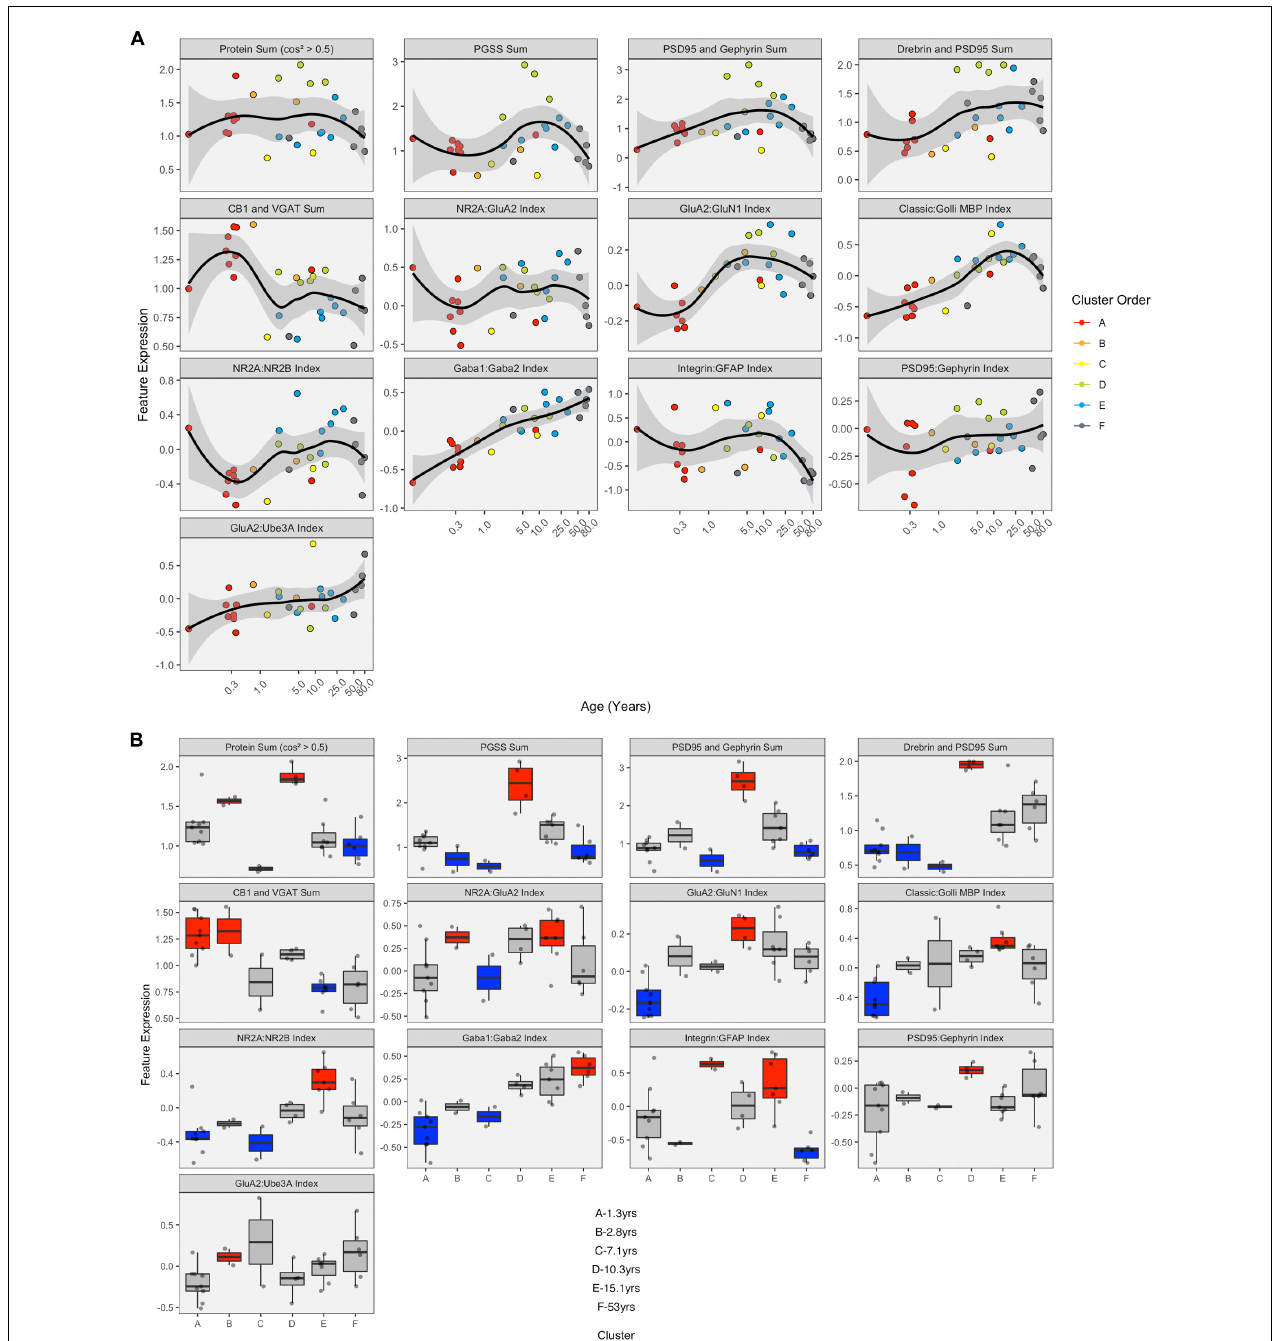
FIGURE 13 | Expression of extracted features with respect to age and by cluster. (A) LOESS trajectories illustrating the expression of protein sums and indices. Points are colored corresponding to the clusters in Figure 8 , and the 95% confidence intervals around each curve are colored in gray. (B) Boxplots show the expression of each feature for the six clusters. A simulated normal distribution was sampled to obtain 5th and 95th percentile values. Boxes were colored red (i.e., over-represented) if the 25th percentile of the feature cluster was greater than the 95th percentile of the normal distribution. Boxes were colored blue (i.e., under-represented) if the 75th percentile of the feature cluster was less than the 5th percentile of the simulated distribution. Otherwise, boxes were colored